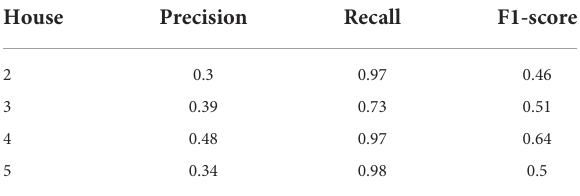
TABLE 7 Evaluation of